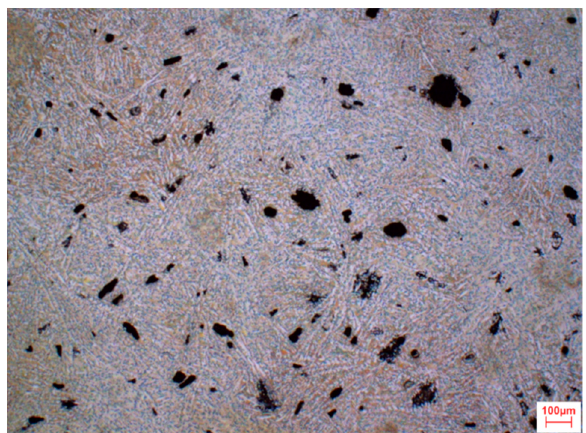
Mg 72 Zn 24 Ca 4 bulk material sample—before the melt spinning process.